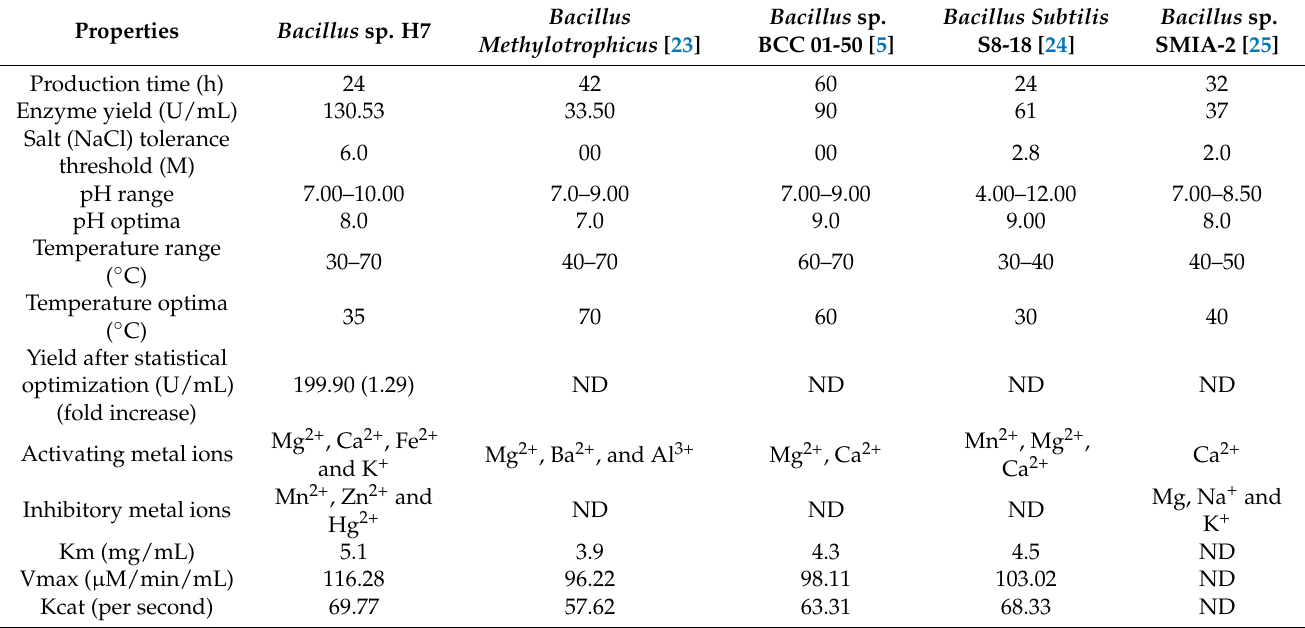
Figure 6. ( A ) Profile of amylase activity at different pH and ( B ) temperature, where optimum pH and temperature is obtained 8 and 40 ◦ C, respectively. ( C ) Influence of various metal ions on the amylase activity. ( D ) Lineweaver–Burk plot of initial rate of reaction against the substrate concentration of soluble starch illustrating amylase activity kinetics parameters. Table 6. Comparative account of characteristics of amylase of Bacillus sp. H7 and amylase of other Bacillus